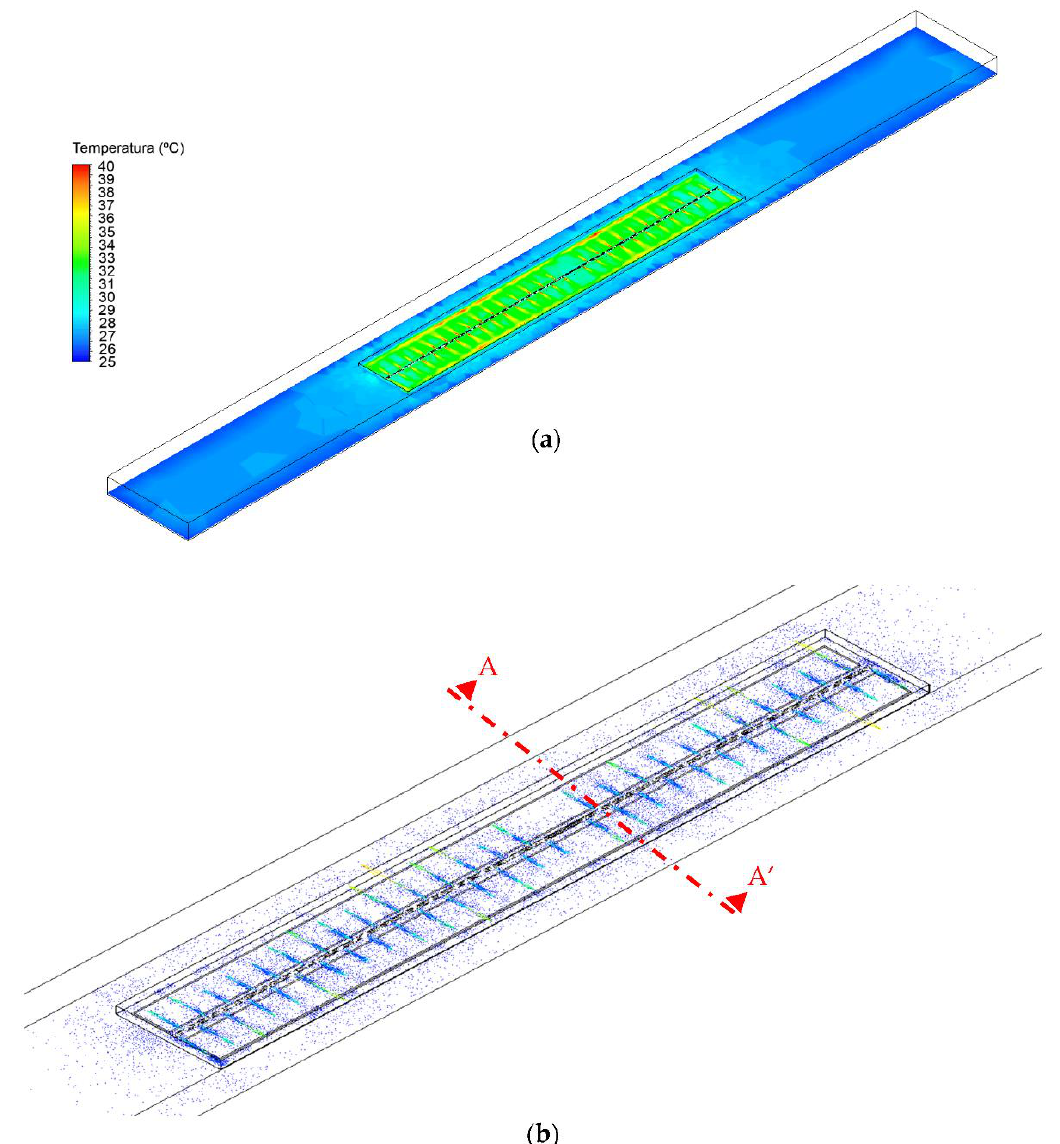
Figure 3. Three-dimensional representation of ( a ) Air temperature distribution inside the broiler house at 0.10 m height and ( b ) air flow distributions inside the studied broiler house with 13 m in width, 160 m in length. Red line indicates the position of the section AA’.